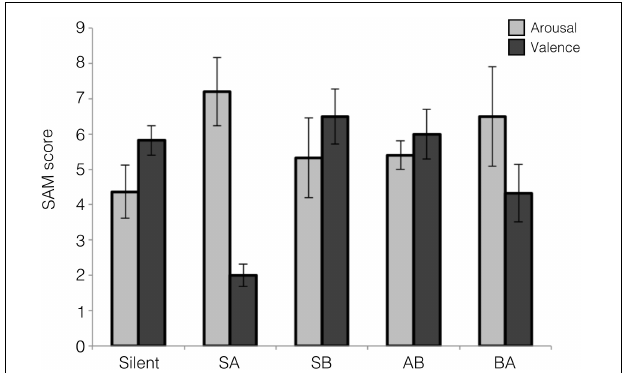
FIGURE 1 | Subjective evaluation of emotional experience with SAM scale. SA: A condition preceded by silent condition, SB: B condition anteceded by silent condition, AB: B condition anteceded by A condition, and BA: A condition anteceded by B condition. The error bars correspond to the standard error of the